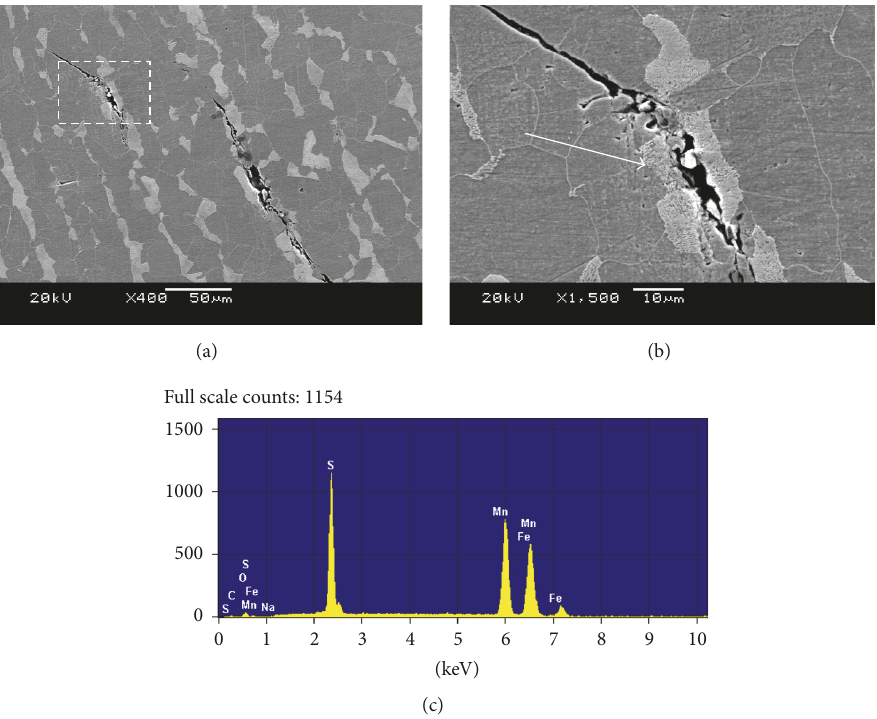
Figure 5: Micrographs showing details of crack nucleation from the inclusion of MnS into the API 5L B steel: (a) 400x and (b) 1500x; (c) EDS analysis of the region indicated by an arrow at (b)